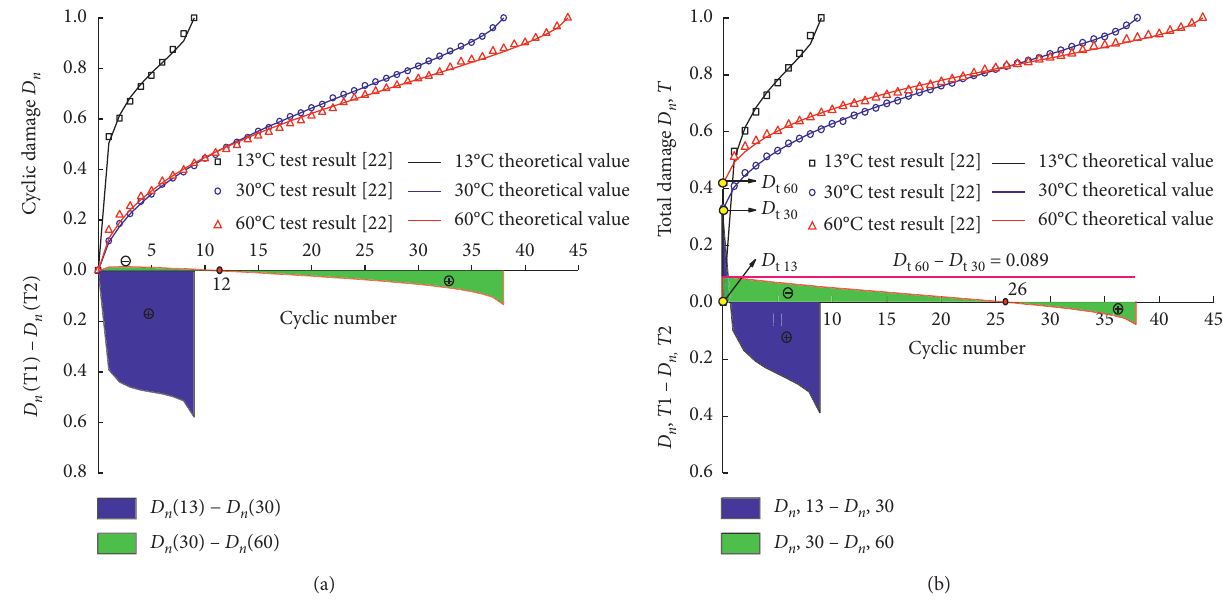
Figure 8: Evolution law of fatigue damage under real-time temperature.